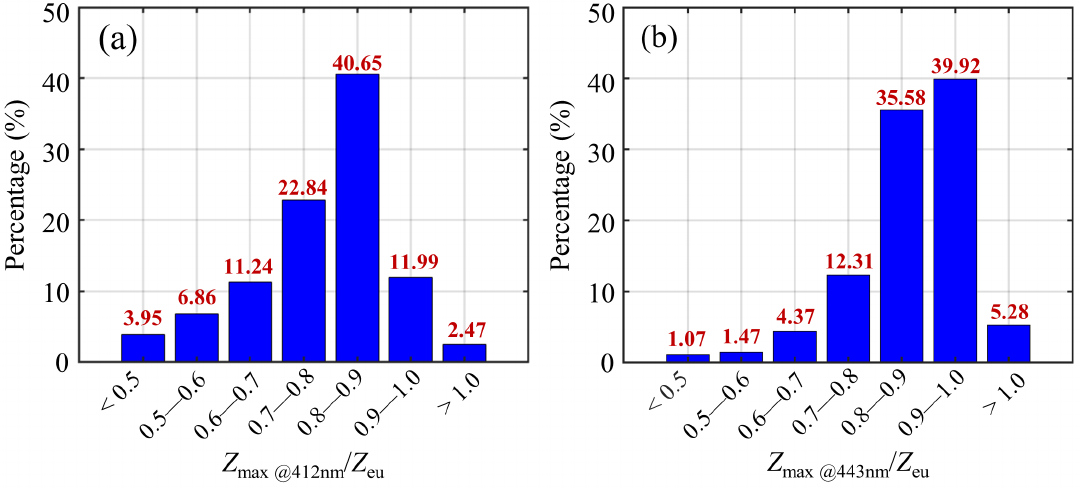
Figure 9. Penetration depth probability at ( a ) 412 nm and ( b ) 443 nm using the method in